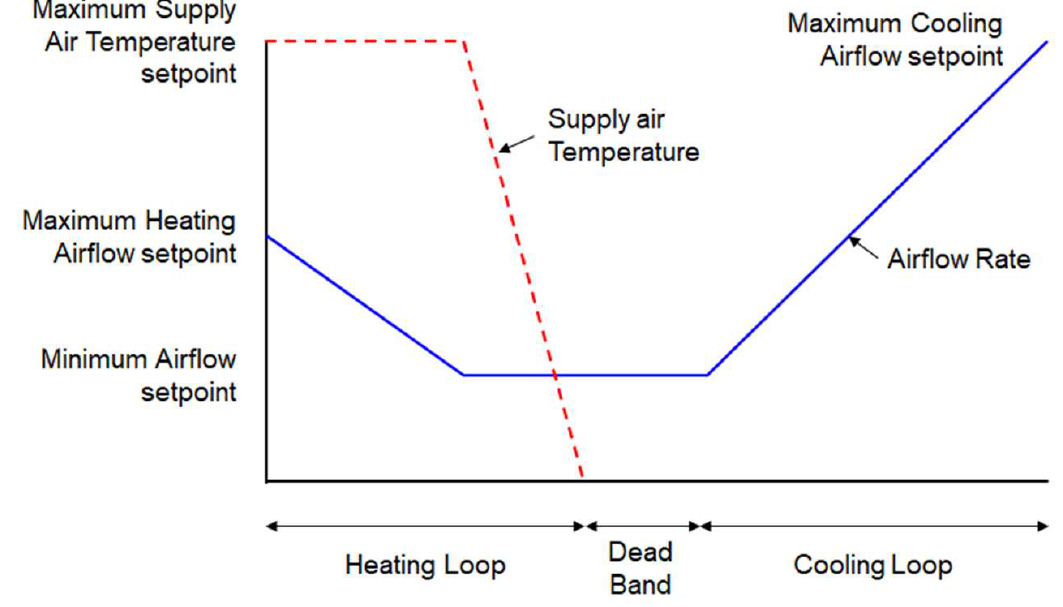
Figure 2. Control Sequence of throttling VAV terminal unit [16].